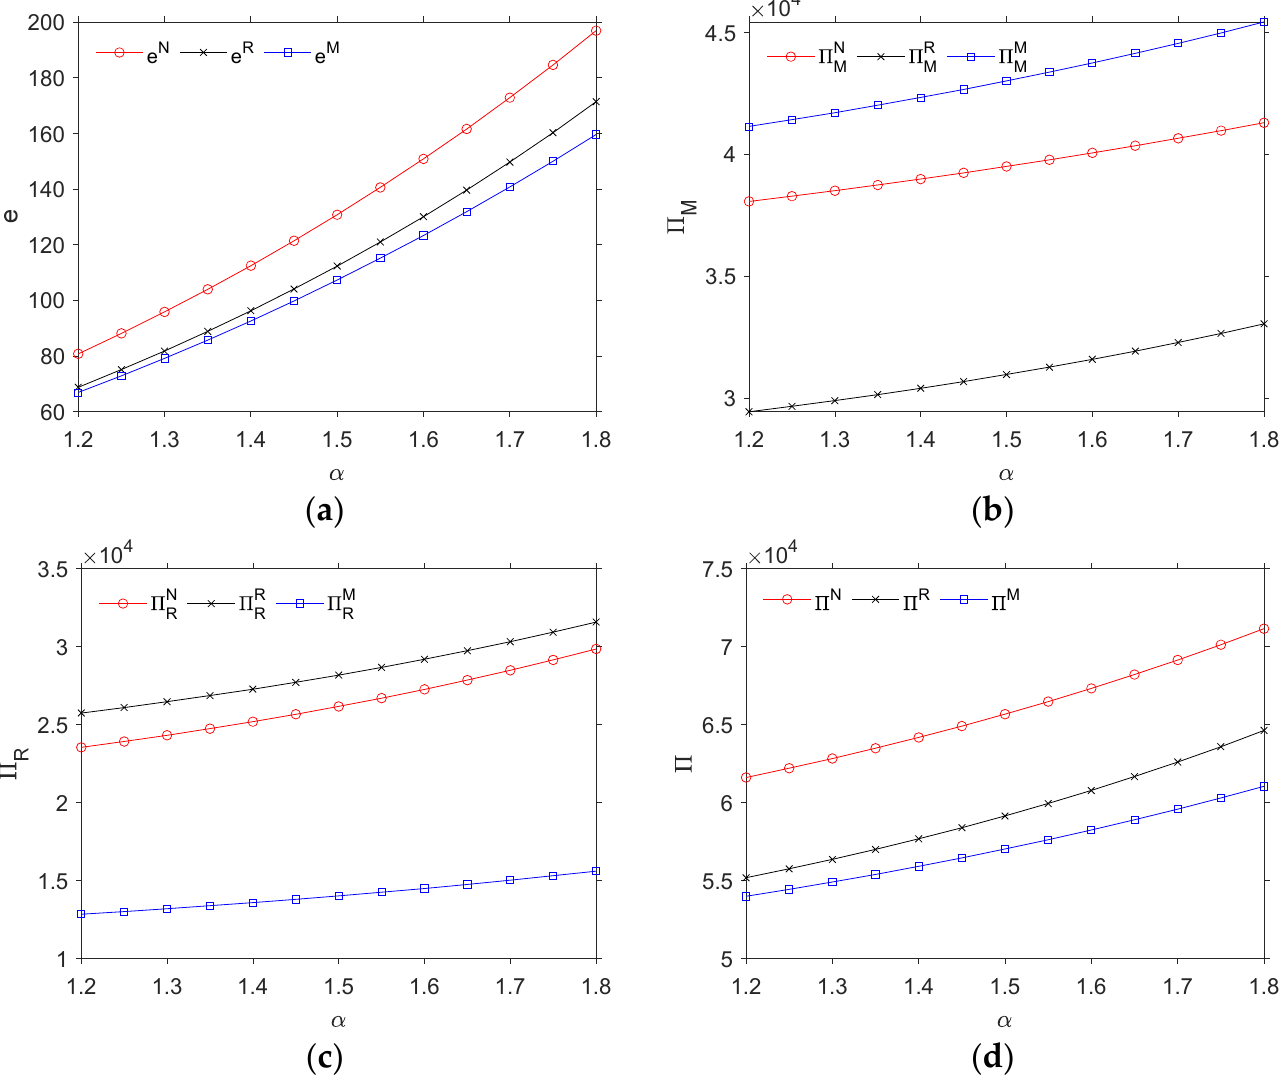
Figure 2. The changes in the supply chain profits ( b – d ) and carbon emissions reduction levels ( a ) that were caused by α .